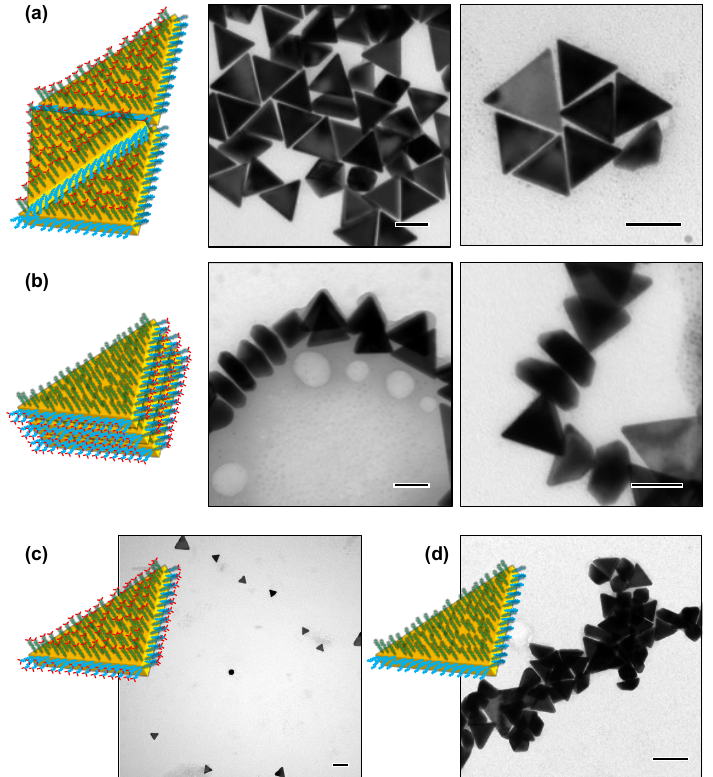
Figure 4. Assembling behaviors of the AuNTs controlled by terminal base pairing of surface-grafted DNA. Representative TEM images for ( a ) the edge-to-edge assembly of the AuNTs modified with fully matched dsDNA on the edges and terminally mismatched dsDNA on the flat surfaces, ( b ) the face-to-face assembly of the AuNTs modified with terminally mismatched dsDNA on the edges and fully matched dsDNA on the flat surfaces, ( c ) stable dispersion of the AuNTs modified with terminally mismatched dsDNA on all surfaces, and ( d ) undirected assembly of the AuNTs modified with fully matched dsDNA on all surfaces. Scale bars are 100